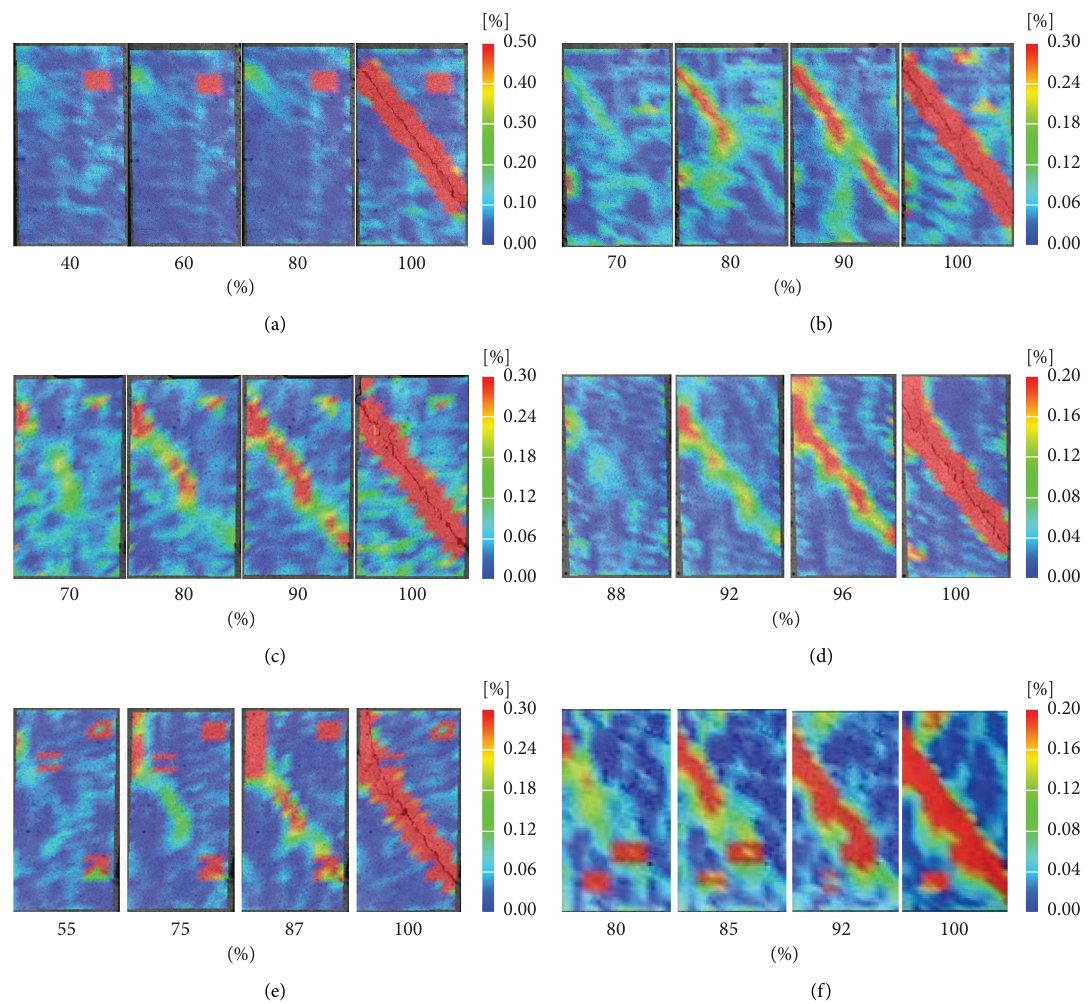
Figure 5: Contour of principal shear strain distribution. (a) Specimen K0-NA-40. (b) Specimen K1-NA-40. (c) Specimen K2-NA-40. (d) Specimen K3-NA-40-3. (e) Specimen K2-NA-30. (f) Specimen